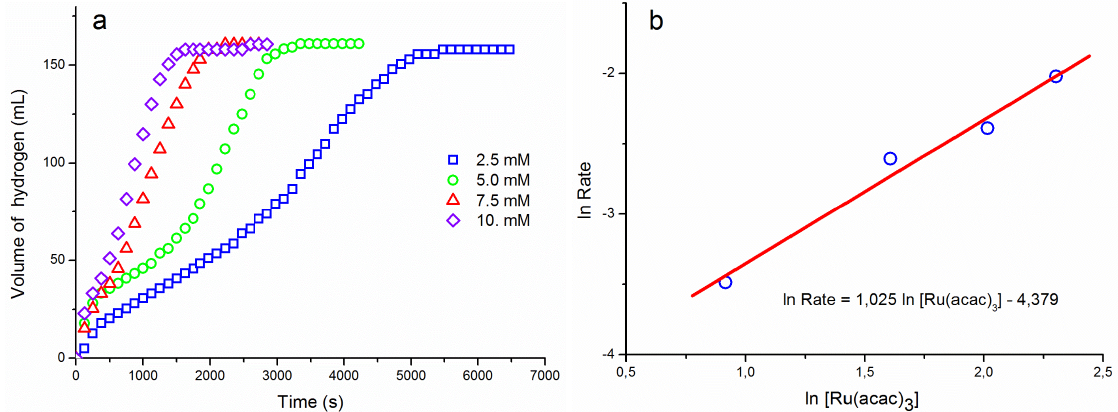
Figure 1. ( a ) Plots of hydrogen volume versus time for the dehydrogenation of dimethylamine borane (500 mM) catalyzed by Ru(acac) 3 as pre-catalyst with different ruthenium concentrations at 60 °C. ( b ) The plot of hydrogen generation rate versus the concentration of ruthenium, both in logarithmic